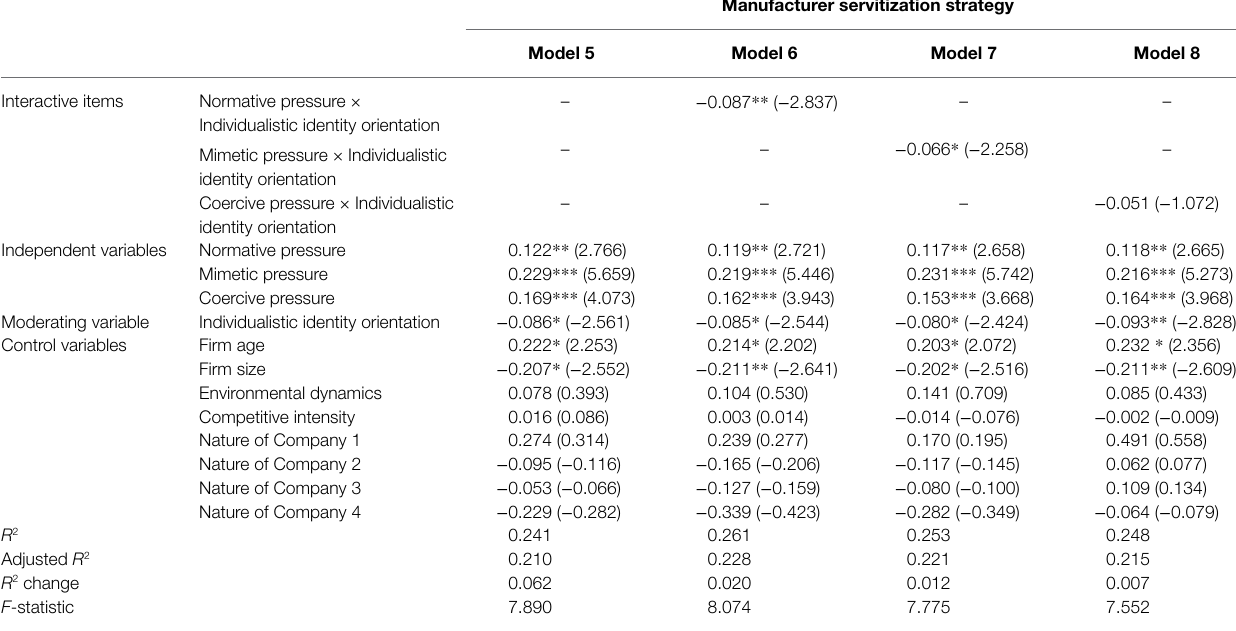
TABLE 6 | The moderating effect of individualistic identity